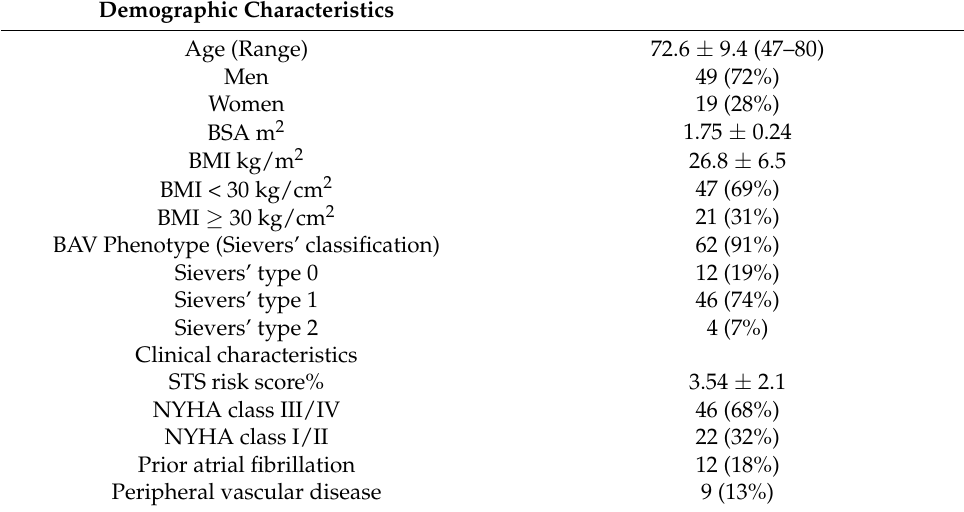
Figure 2. Cumulative curve showing the age groups of the included patients in the registry. The figure shows the cut-off age recommended by the ACC/AHA, 2020 and ESC/EACTS 2021 guidelines. Table 1. Patients’ demographic and clinical characteristics of the patients included in the Myval bicuspid registry.